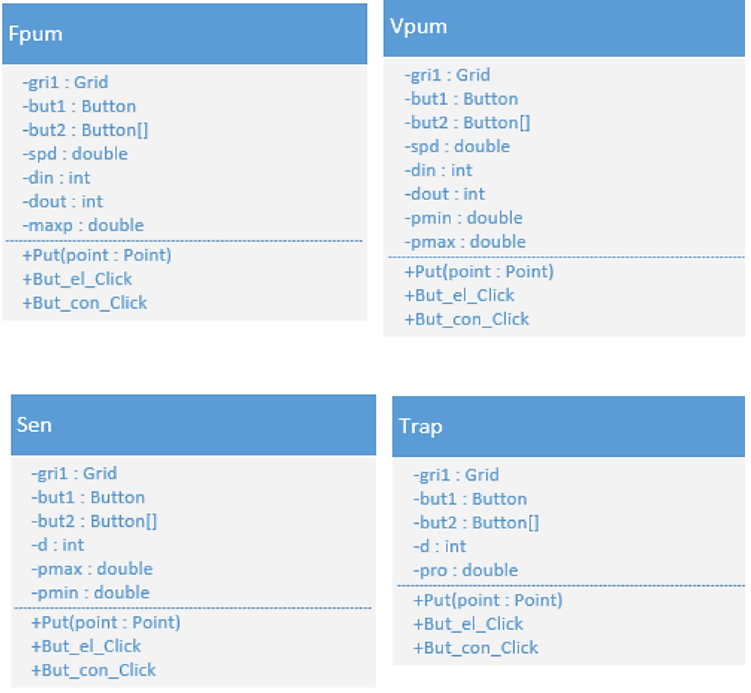
Fig. 3. An example of selected classes of